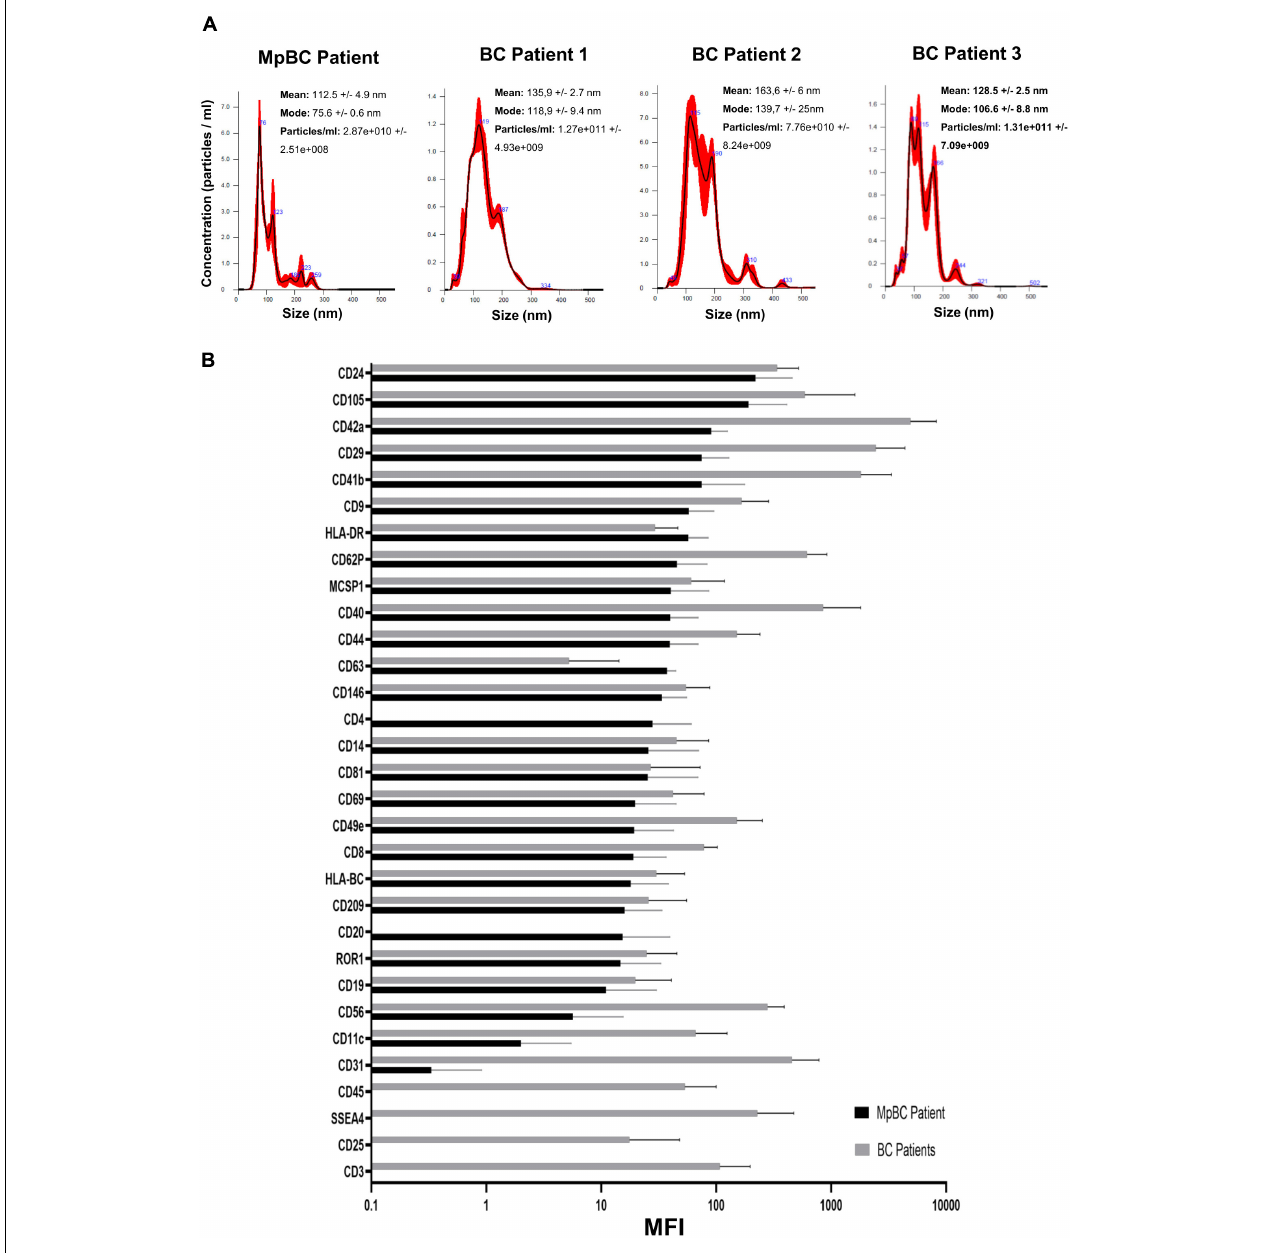
FIGURE 2 | (A) NTA profile analysis of SEC fractions with highest concentration of EVs obtained from MpBC patient plasma and 3 metastatic breast cancer patients. (B) Protein expression of each plasma EVs marker by flow cytometry. Values refer to Mean Fluorescence Intensitiy (MFI) ± s.d. of the most concentrated fractions. In black, the values obtained from MpBC EVs and in gray the values of 3 Breast Cancer EVs. Values have been normalized to blank